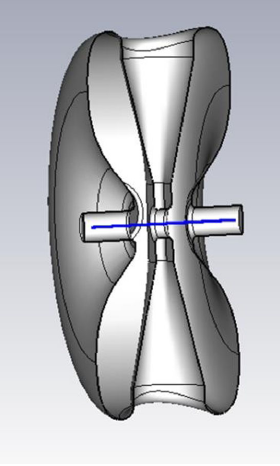
FIG. 10. Optimized geometry of the Spoke012